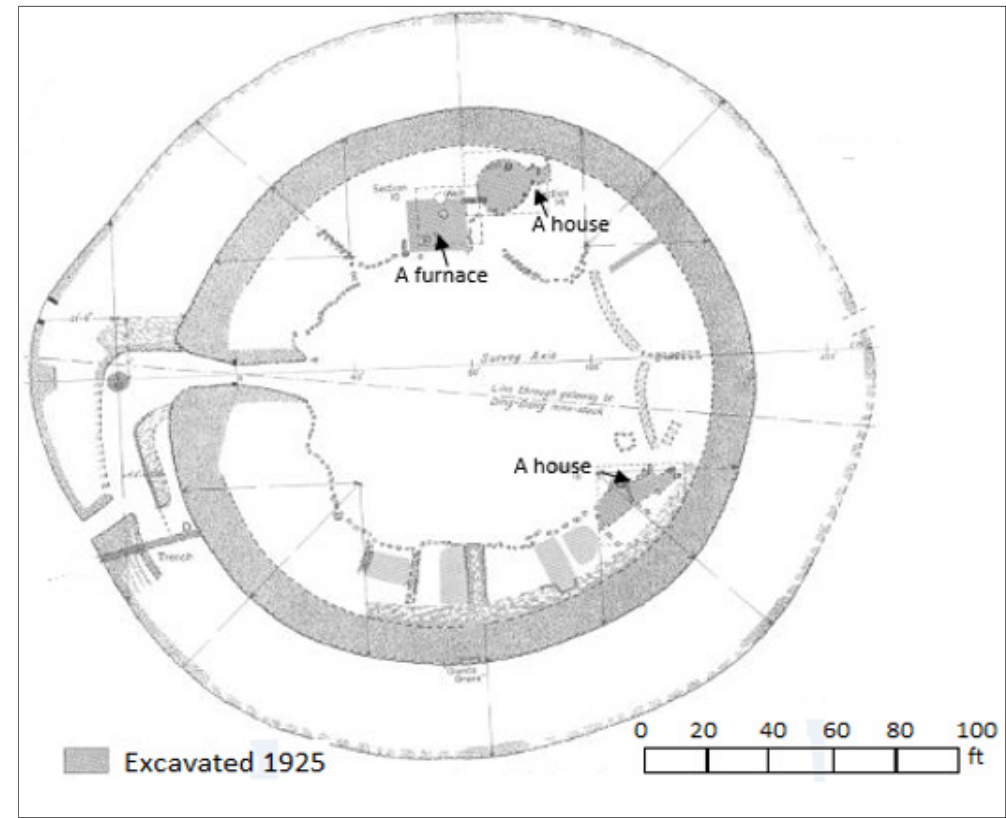
Figure 9. Archaeological monuments in Chun Castle study site revealed from [3] findings using excavation methods. This figure adapted from Figure 3 in [3] study.